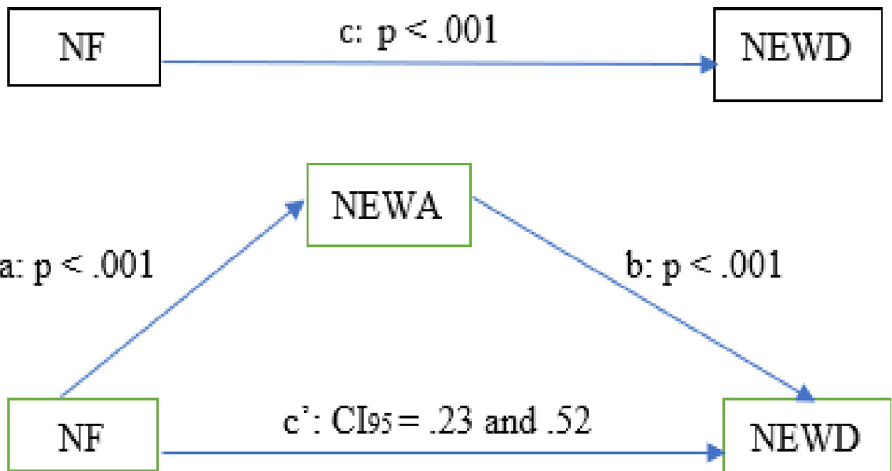
Fig 2. Model of the mediating role of NEWA between NF and NEWD.